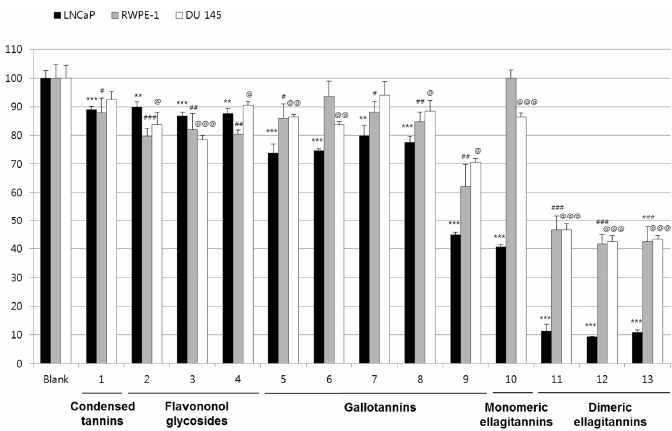
Figure 2. The antiproliferative effects of 1 – 13 from C. alba . Each compound was treated at the concentration of 50 μ M into androgen-dependent prostate tumor LNCaP, androgen-independent prostate tumor DU145 and normal prostate epithelial RWPE-1 cells. The results were expressed as mean ± S.D. of triplicated experiments. **: p < 0.01, ***: p < 0.001, compare with LNCaP Blank group; Table 2. IC 50 values of 9 – 13 against the cell viability of LNCaP and DU145. Samples